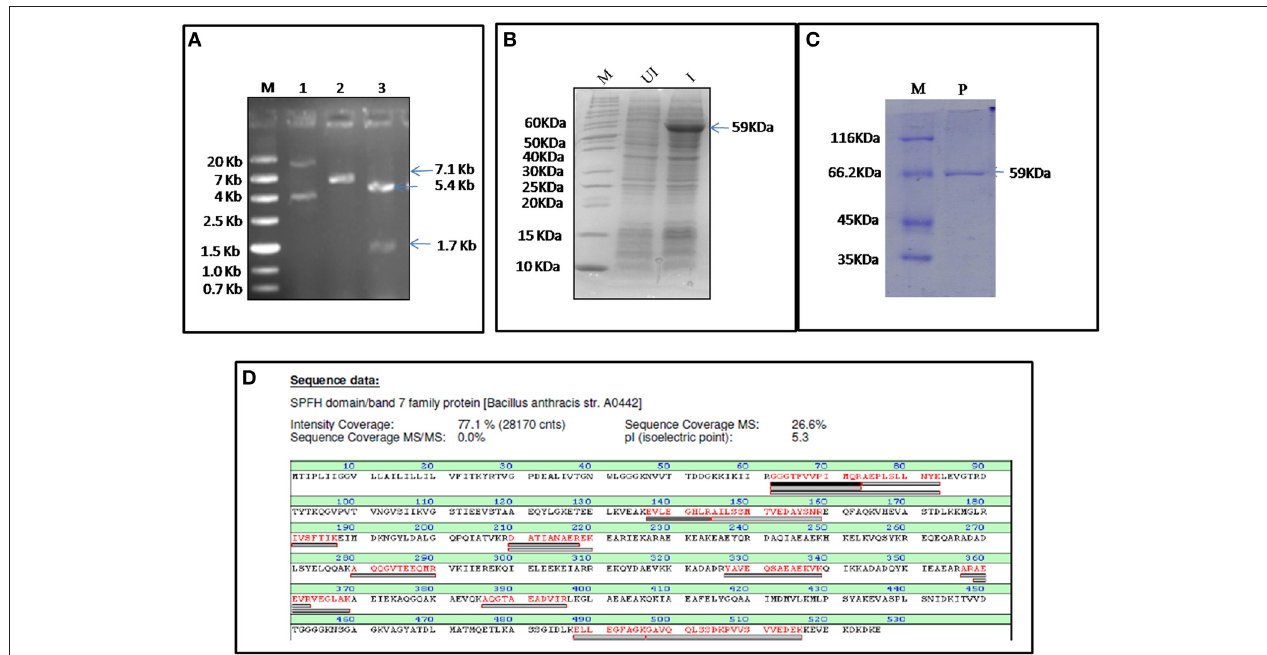
FIGURE 2 | Cloning, expression, and purification of FlotP. (A) Clone confirmation by restriction digestion of pET28a- flotP . Double digestion (DD) confirmed the presence of insert by fall out at 1.7 Kb corresponding to flotp size. Lanes: M- Marker (ZipRuler TM ; #SM1373), 1- pET28a- flotP , 2- Single digest, 3-double digest. (B) Overexpression of FlotP in BL21 ( λ DE3) E. coli cells. Lanes: M, Marker (Pageruler unstained; #26614); UI, Uninduced, and I, Induced. (C) Purification by Ni-NTA chromatography. Lanes: M, Marker (Pierce TM Unstained Protein MW Marker; #26610); P, Purified Protein. (D) MALDI analysis showing the sequence of the protein with the peptide coverage marked in red. The peptide hits showed highest similarity to SPFH domain BAND 7 family protein of B. anthracis i.e.,